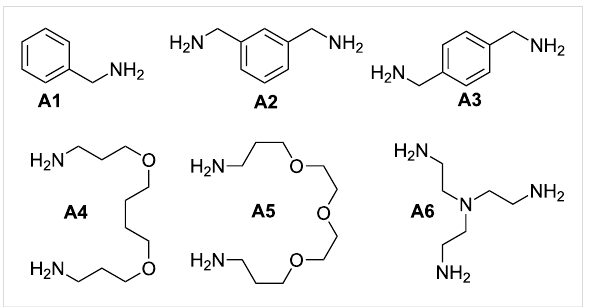
Figure 1: Amines used for the synthesis of